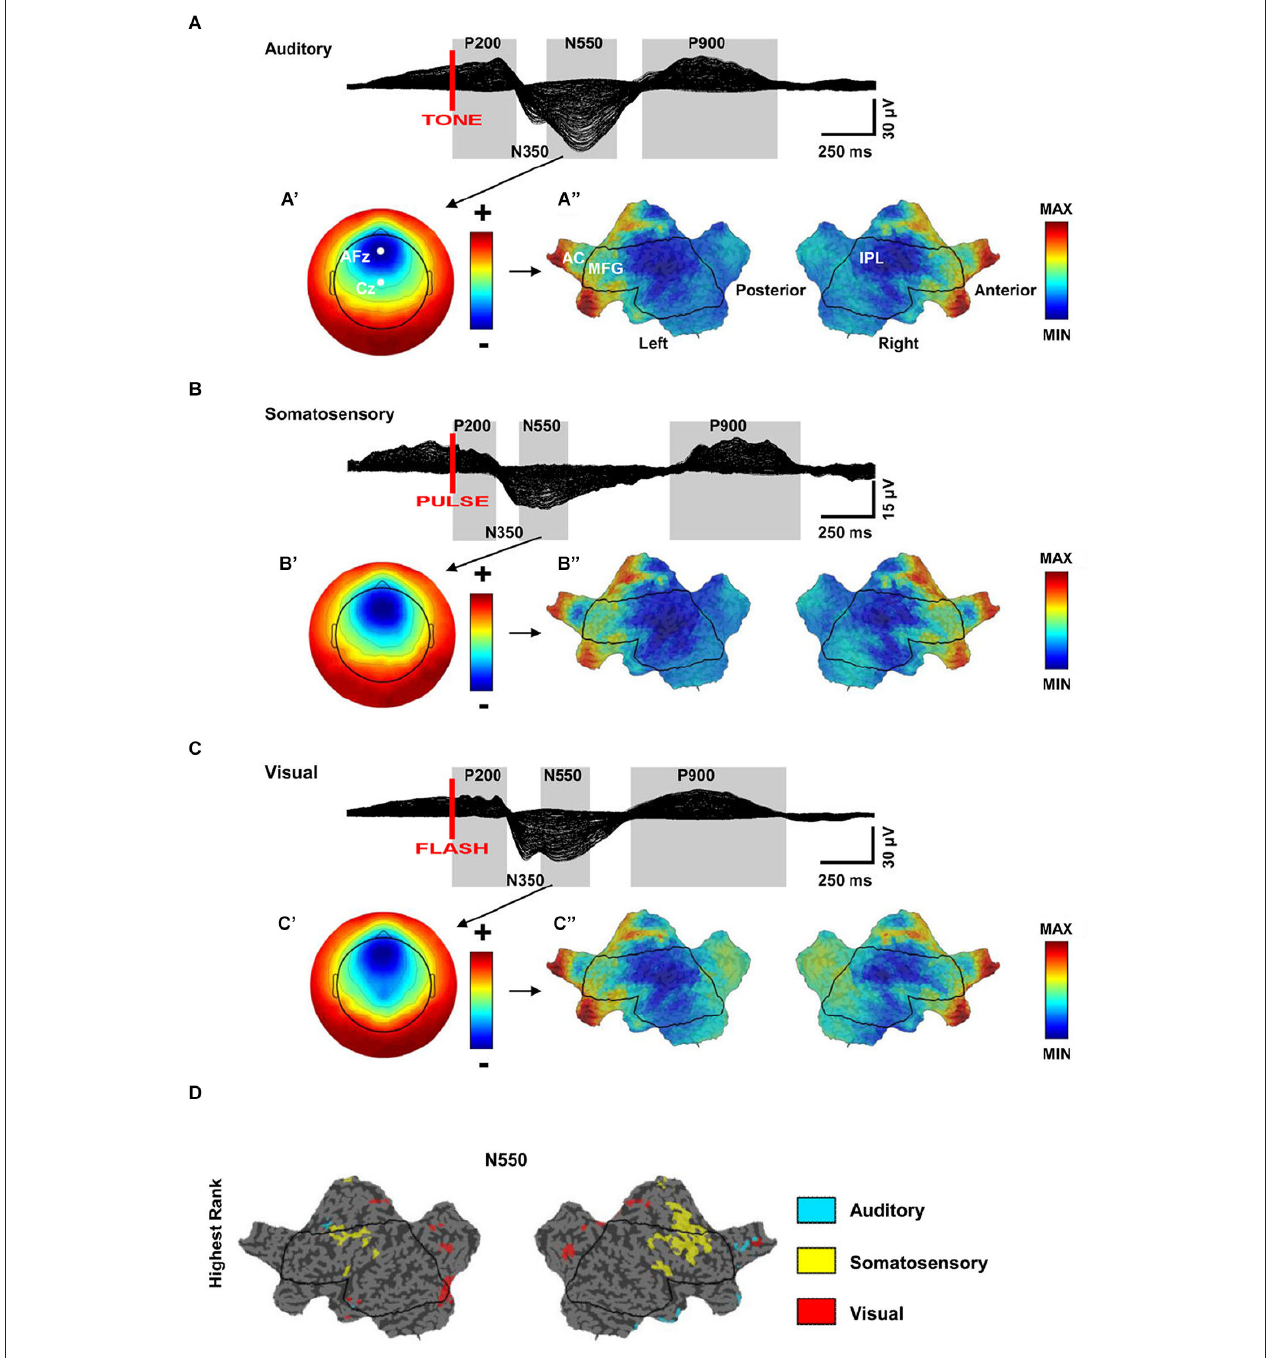
sources for the N550 peak. Current hot spots (most current) indicated in red, cold spots in blue. AC = Anterior Cingulate, MFG = Middle Frontal Gyrus, IPL = Inferior Parietal Lobule. (ABC”) , respectively MIN = − 1.3, − 1.2, − 1.4; MAX = 2.6,2.5,2.3. (D) Modality-specific differences in cortical sources for the N550 peak of KC. Flat map of significantly different cortical sources across stimulation modalities (Quade test, p < 0.05). Color-coding of voxels indicates the stimulation with the highest ranking relative to the other stimulation modalities (adapted from Riedner et al.,